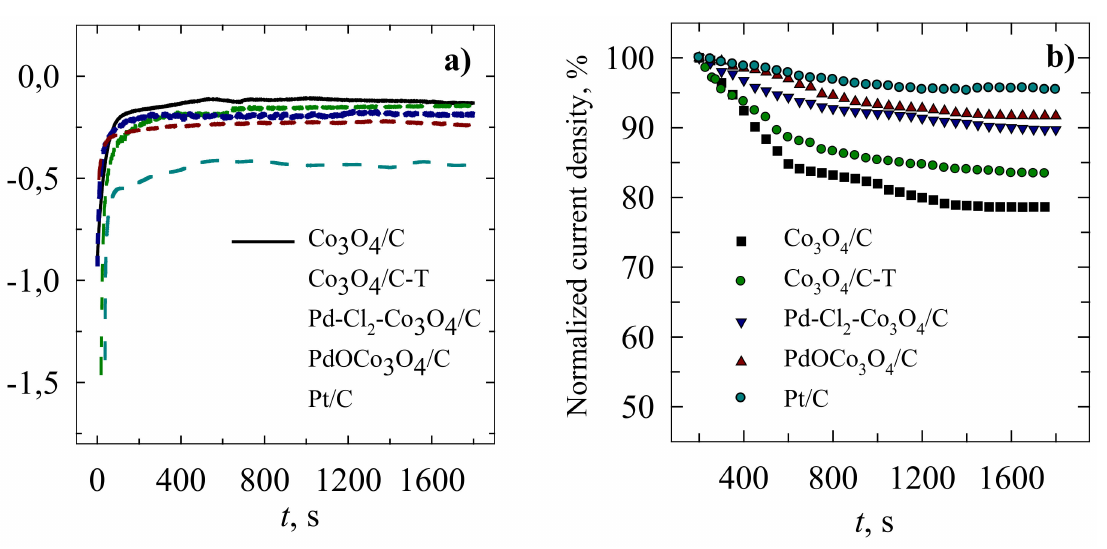
Figure 8. Chronoamperometric curves recorded on the investigated catalysts at 0.55 V in an O 2 -saturated 0.1 M NaOH solution: ( a ) chronoamperometric responses (percentage of current density retained vs. operation time) of all the catalysts ( b